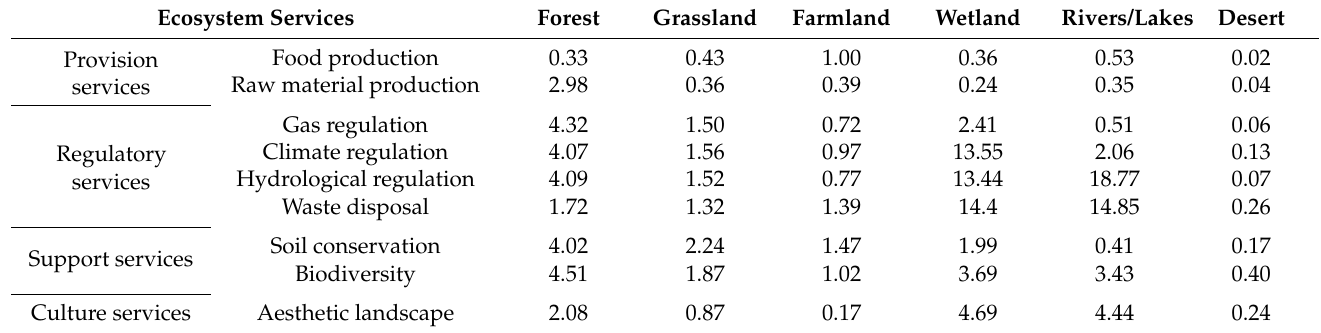
Table 2. Equivalent table per unit area of terrestrial ecosystem in China (data based on reference